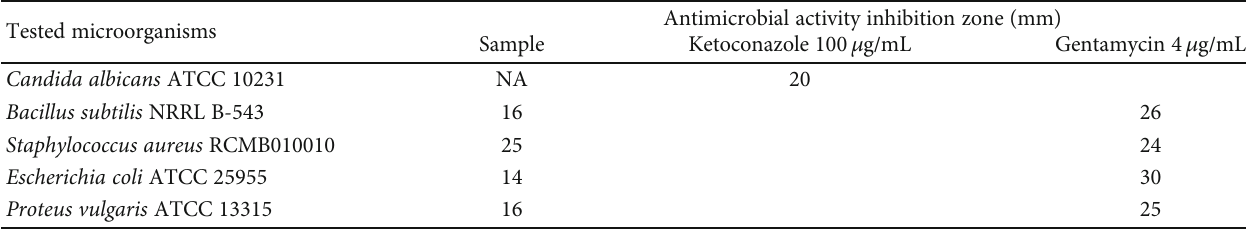
Figure 7: Antimicrobial activity of the biosynthesized CdSNPs against Gr + bacteria, Gr - bacteria, yeast, and fungi in comparison to gentamycin and ketoconazole. Table 1: Antimicrobial activity of the biosynthesized CdS nanoparticles against Gr + bacteria, Gr - bacteria, yeast, and fungi in comparison to gentamycin and